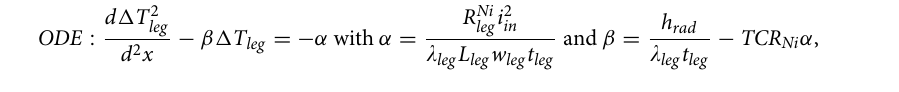
Figure 5. ( a ) TCR of the nickel resistor with two measurement methods: directly on MEMS using a heating four-probe station ( (cid:31) ) and on an annealed blanket thin film using a Van der Pauw configuration ( Thermal balance in legs with the temperature rise profile for heated (red) and unheated (blue) legs for modelling of conduction losses from the membrane through legs. ( c ) Far field membrane resistance and heated leg resistance function of applied current. Experimental thermal characteristic for legs (average temperature, grey circles) and for the membrane (black square). Corresponding thermal model with (cid:31) Ellipsometry ( (cid:31) and (cid:31) ) angles of SiO 2 (black) and SiN (grey) respectively with a 40 ◦ and 65 ◦ incidence angle. Points are the experimental data and lines represent the fit using Brendel L leg ) is at the temperature of the membrane. The temperature rise (cid:31) T leg follows the differential frontier ( x = equation system: